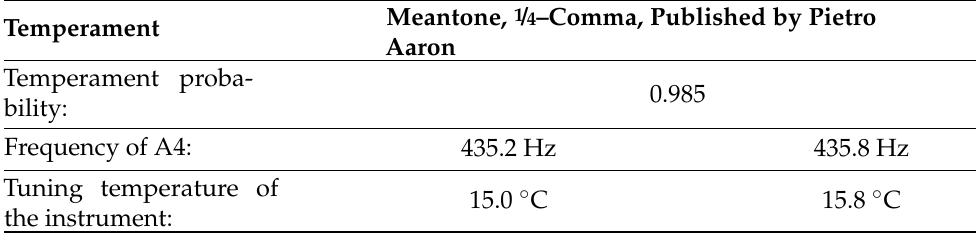
Table 5. Reconstructed temperament of the Kamie´n Pomorski chest organ.